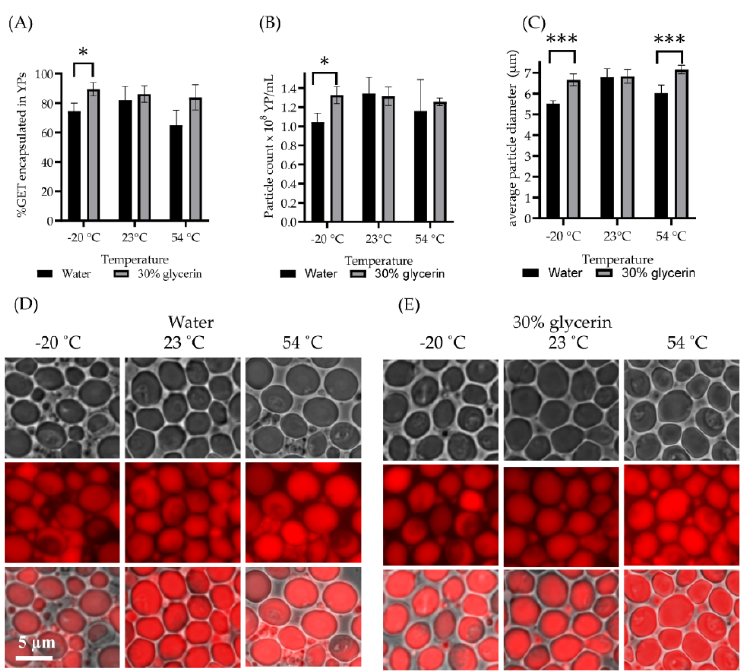
Figure 6. YP-GET (10% YP, GET:YP ratio of 3.5:1) prepared in water as loading solvent and 30% glycerin–70% water in stabilized YP-GET formulation. Results show ( A ) % GET encapsulation, ( B ) particle count, ( C ) average particle diameter, and ( D ) microscopy of samples after temperature stress (repeated freeze/thaw cycles and two-week storage at 23 °C and 54 °C). Statistically significant results were determined by t -test (* p <0.1, *** p < 0.001).